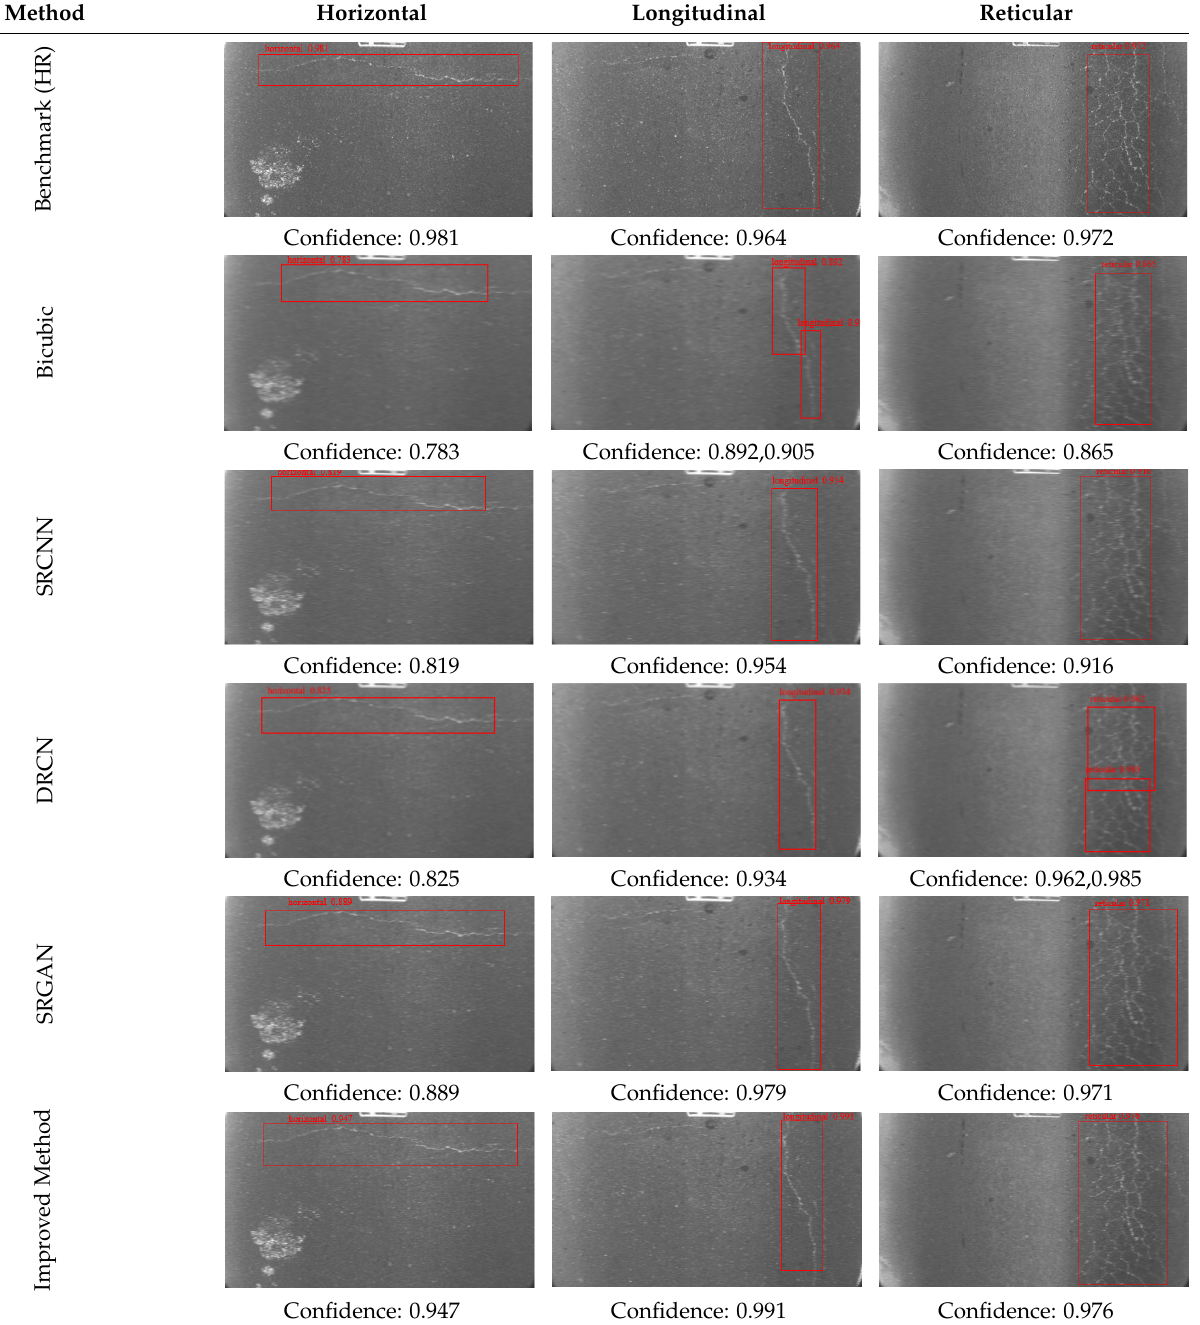
Table 6. Table 6. Comparison of crack detection results and confidence. Table 6. Comparison of crack detection results and confidence. Table 6. Comparison of crack detection results and confidence. Table 6. Comparison of crack detection results and confidence. Table 6. Comparison of crack detection results and Table 6. Comparison of crack detection results and confidence. Table 6. Comparison of crack detection results and confidence. Table 6. Comparison of crack detection results and confidence. Table 6. Comparison of crack detection results and confidence. Table 6. Comparison of crack detection results and confidence.